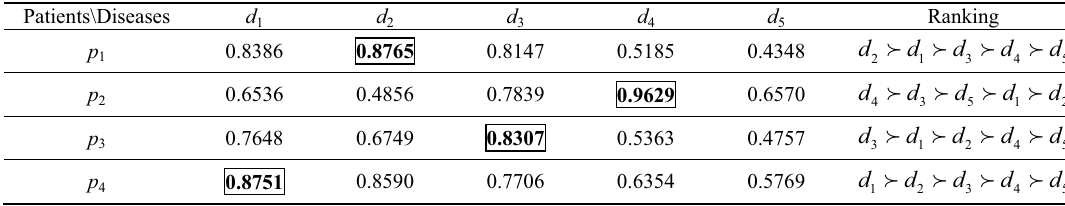
Table 3. The diagnostic results by the proposed approach.